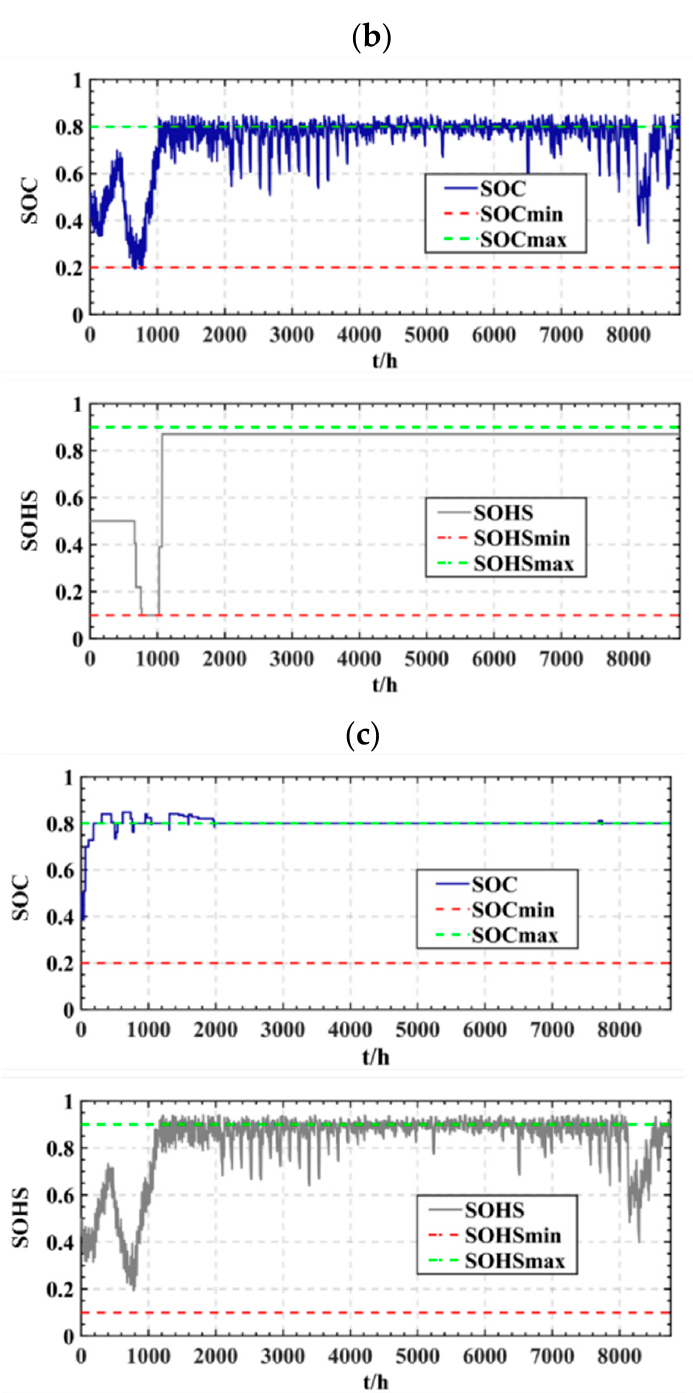
Figure 8. Annual energy storage changes of the storage battery and the hydrogen storage tank: ( a ) scheduling strategy in this paper; ( b ) battery priority scheduling strategy; ( c ) hydrogen energy system priority scheduling strategy.